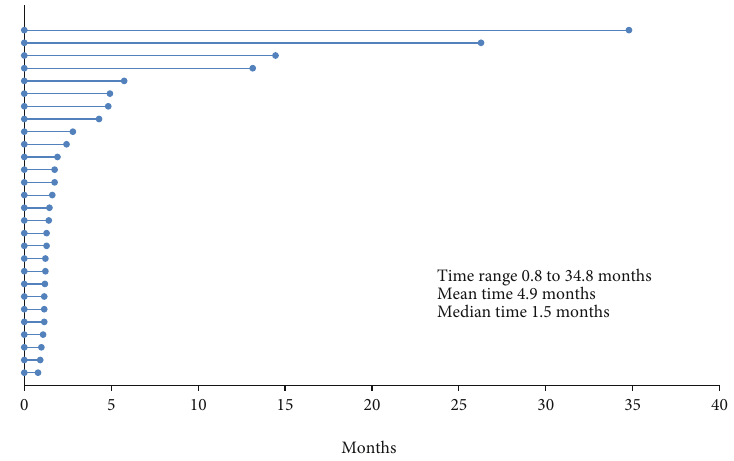
Figure 3: TGA were detected earlier in months in 28 children with multiplex ECL assay than RBA. The beginning of each line is TGA detecting time as the baseline of time with ECL assay for a child and the end of line is TGA detecting time with